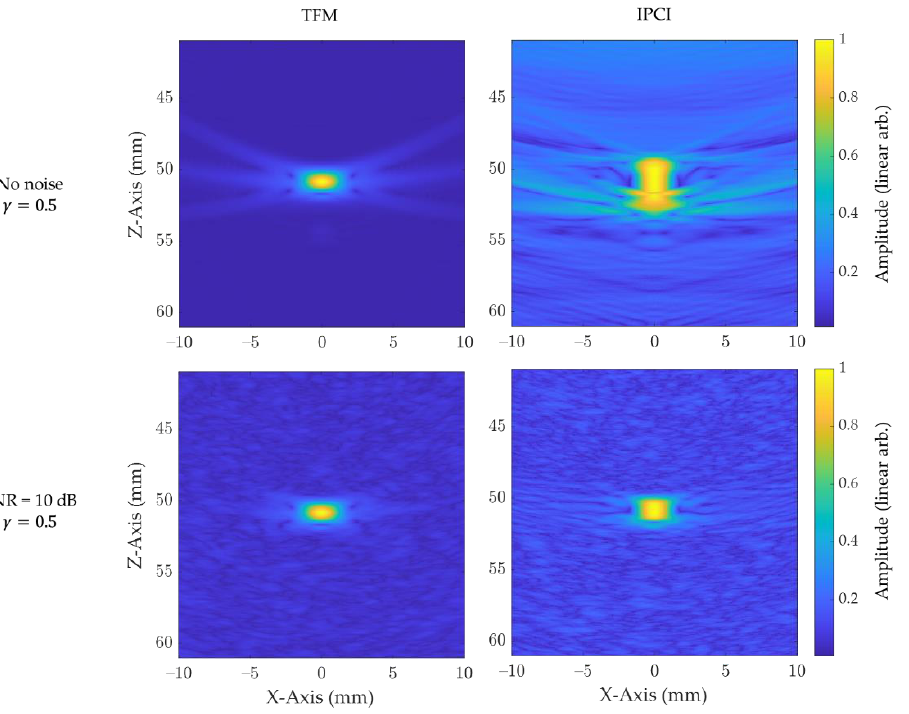
Figure 5. Simulated noise sensitivity for a point like scatterer, using both instantaneous phase coherence imaging (IPCI) and the conventional total focusing method (TFM). The upper row images were generated using raw time traces, while the lower row images where generated with a signal-to-noise ratio (SNR) of 10 dB. A gamma correction factor of 0.5 was applied to all images.